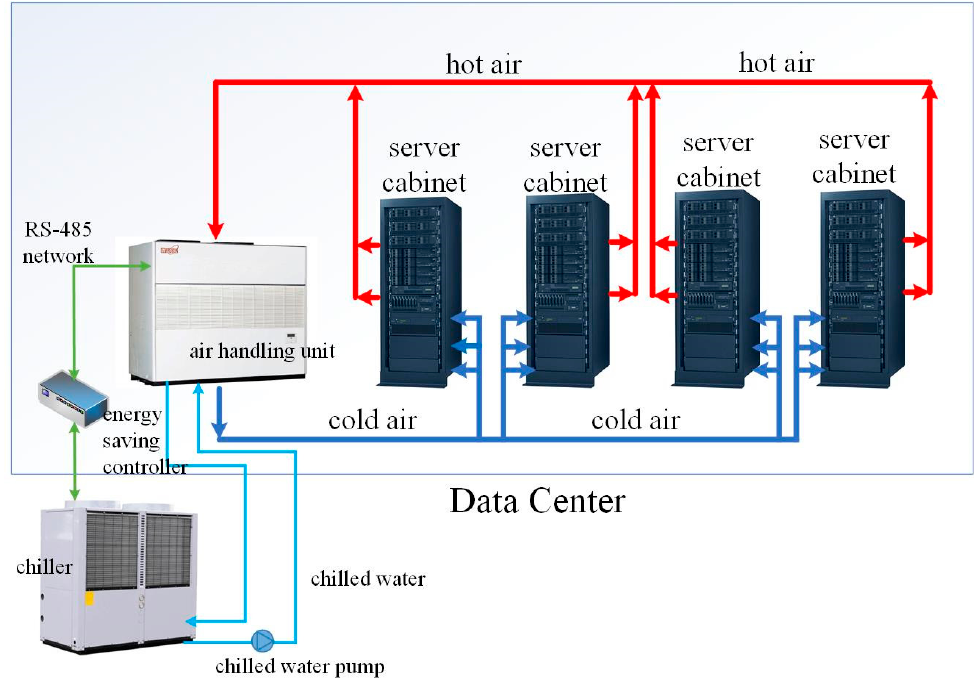
Figure 1. System structure of energy saving control for data center air conditioning system.